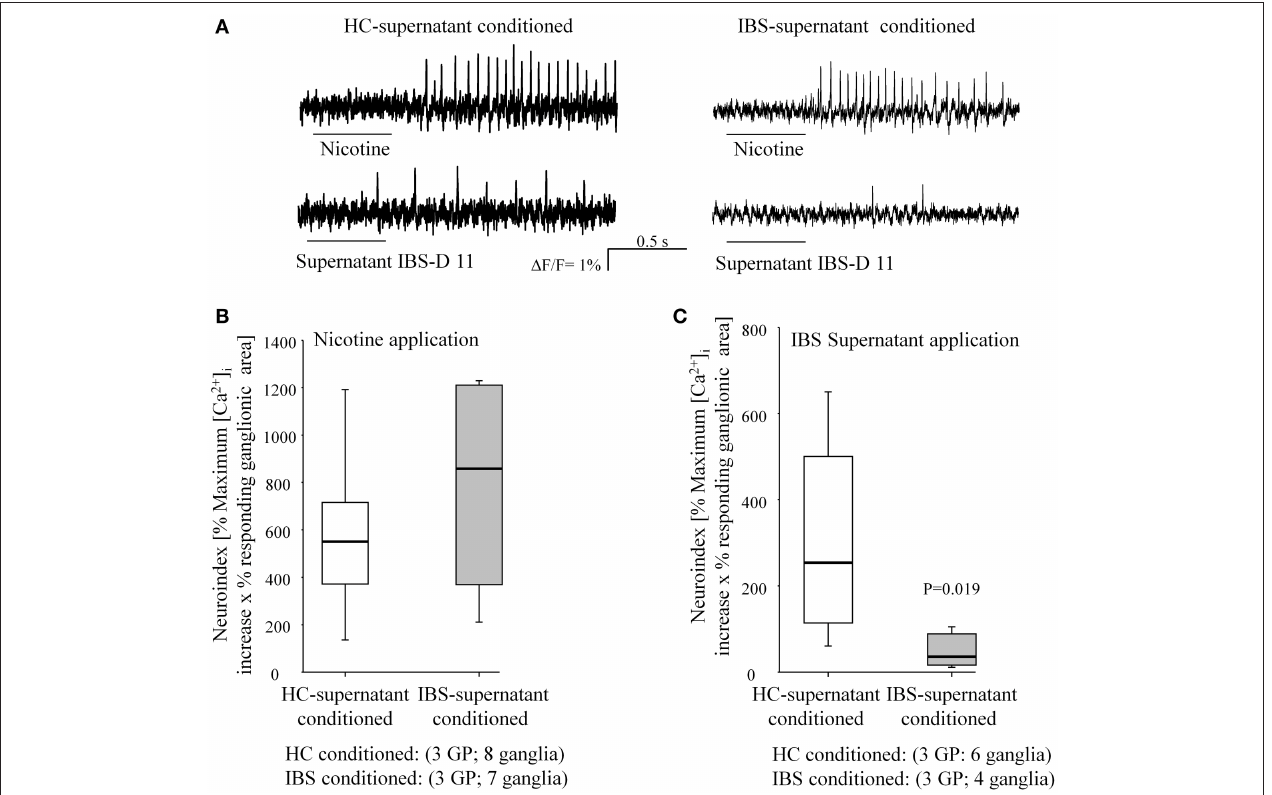
FIGURE 4 | Overnight incubation with an IBS biopsy supernatant but not with a HC biopsy supernatant desensitized the neurons to application of IBS supernatant. (A) Representative traces to spritz application of nicotine or IBS supernatant in HC and IBS preincubated tissues. (B) Nicotine evoked responses, expressed as neuroindex, were comparable in tissues conditioned by IBS or HC supernatants. (C) Application of the IBS supernatant which had been used to condition the tissues ( = IBS conditioned) evoked a significantly smaller neuronal activity in IBS compared to HC-conditioned tissue as revealed by a reduced